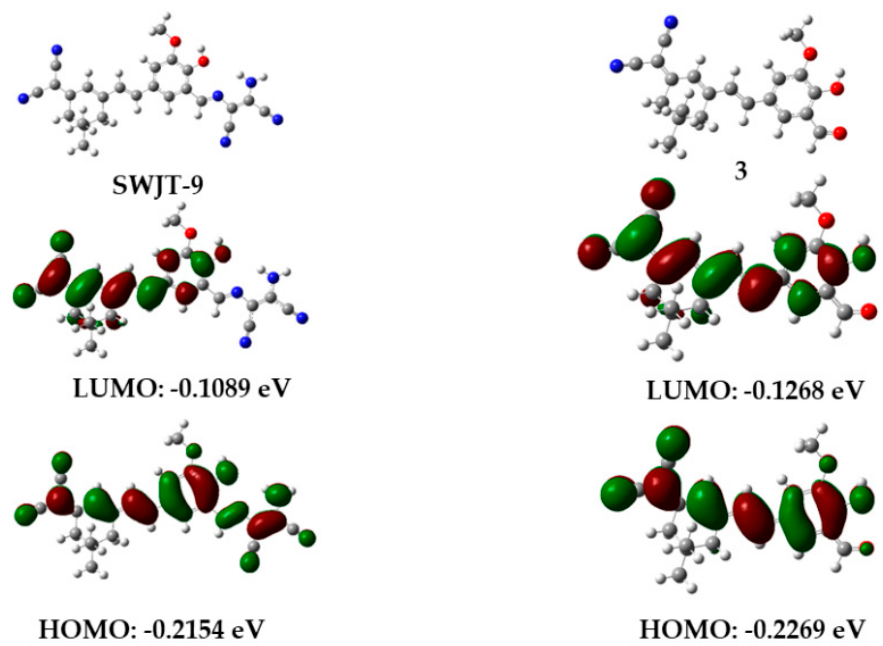
Figure 4. Optimized structures and molecular orbital plots of SWJT-9 and compound 3 .